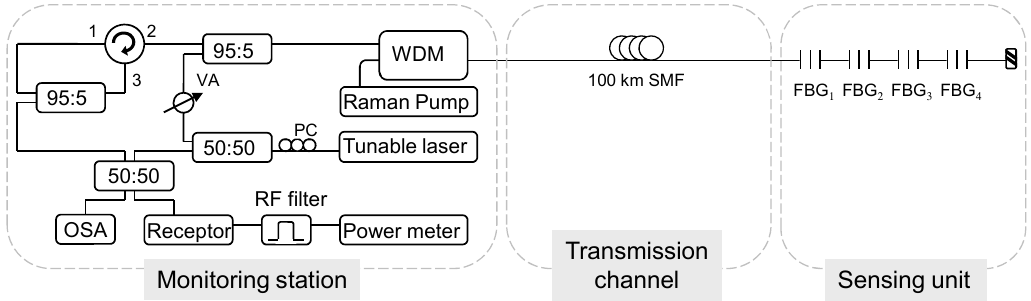
Figure 6. Experimental set-up for the FBG interrogation technique for remote sensing. Adapted from